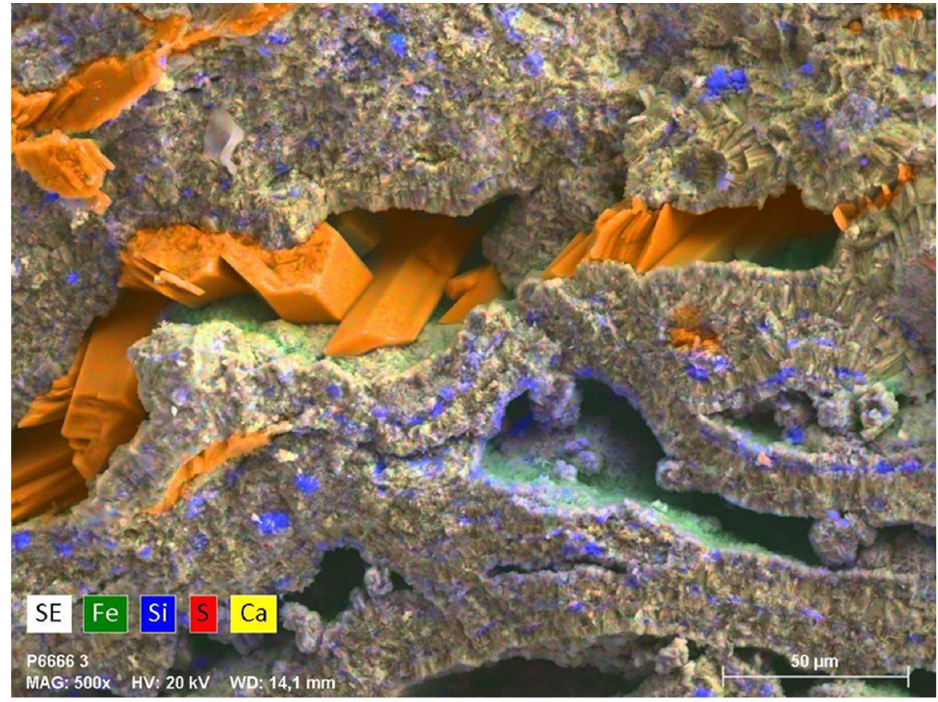
Figure 8. Overlayered elemental mapping of iron, silica, sulfur, and calcium acquired from a longi- tudinal thin section sample from the Stefføya site. Formation of gypsum crystals (bright orange colored) inside cavities of the crust, enhancement of iron compounds (likely iron